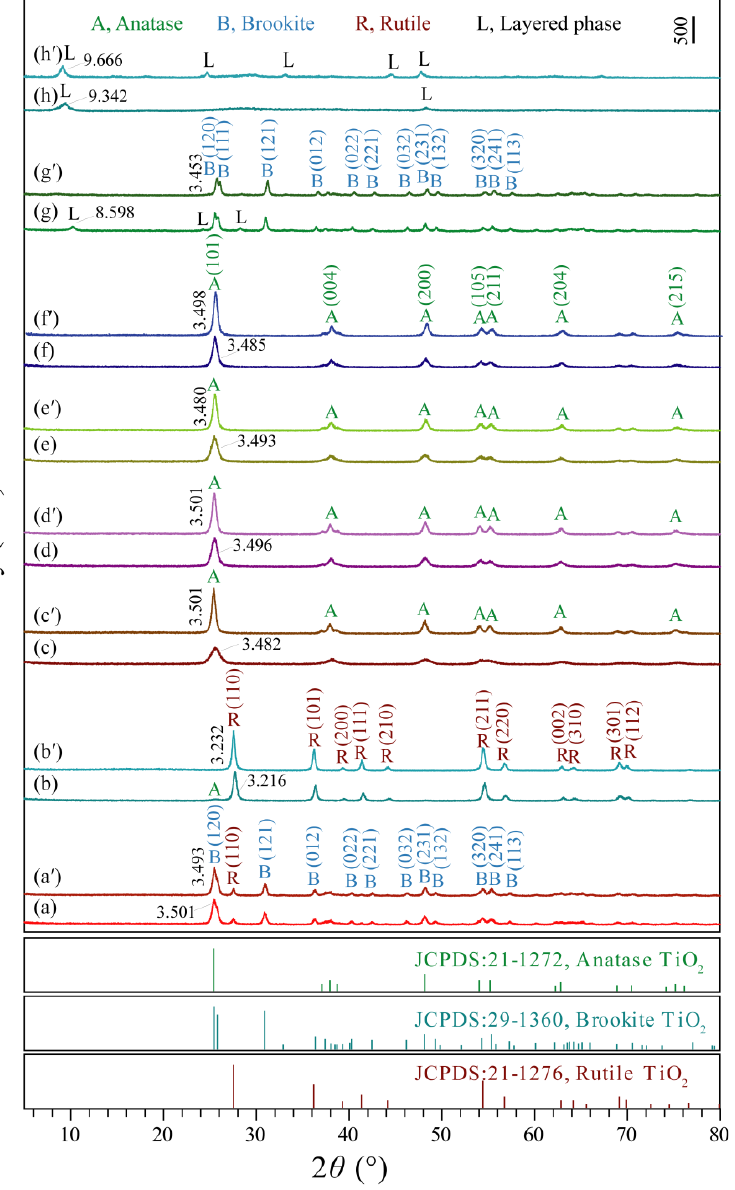
Figure 1. XRD patterns of ( a ) pH0.5 − TiO 2 , ( b ) pH1.5 − TiO 2 , ( c ) pH3.5 − TiO 2 , ( d ) pH5.5 − TiO 2 , ( e ) pH7.5 − TiO 2 , ( f ) pH9.5 − TiO 2 , ( g ) pH11.5 − TiO 2 and ( h ) pH12.5 − TiO 2 samples hydrothermally syn- thesized at 180 °C for 24 h under different pH conditions and ( aʹ ) pH0.5 − T500 − TiO 2 , ( bʹ ) pH1.5 − T500 − TiO 2 , ( cʹ ) pH3.5 − T500 − TiO 2 , ( dʹ ) pH5.5 − T500 − TiO 2 , ( eʹ ) pH7.5 − T500 − TiO 2 , ( fʹ ) pH9.5 − T500-TiO 2 , ( gʹ ) pH11.5 − T500 − TiO 2 and ( hʹ ) pH12.5 − T500 − TiO 2 products obtained by calcin- ing the hydrothermally synthesized pH x -TiO 2 samples at 500 °C for 3 h. Figure 1aʹ–hʹ show the XRD patterns of as-prepared pH x -T500-TiO 2 products. The average crystallite sizes of the synthesized TiO 2 products estimated from the full width at half-maximum (FWHM) of XRD peaks using Scherrer equation [23] D = 0.89λ/ β cosθ (λ, the wavelength of X-ray irradiation (Cu Ka = 0.15406 nm); β , the FWHM of the diffraction peak; θ, the X -ray diffraction angle) are 20.7 (22.3), 20.1 (25.0), 7.4 (18.2), 11.4 (16.5), 10.4 (15.8), 13.5 (16.6) and 29.6 (34.8) nm for pH0.5-TiO 2 (pH0.5-TiO 2 -T500), pH1.5-TiO 2 (pH1.5-TiO 2 -T500), pH3.5-TiO 2 (pH3.5-TiO 2 -T500), pH5.5-TiO 2 (pH5.5-TiO 2 -T500),